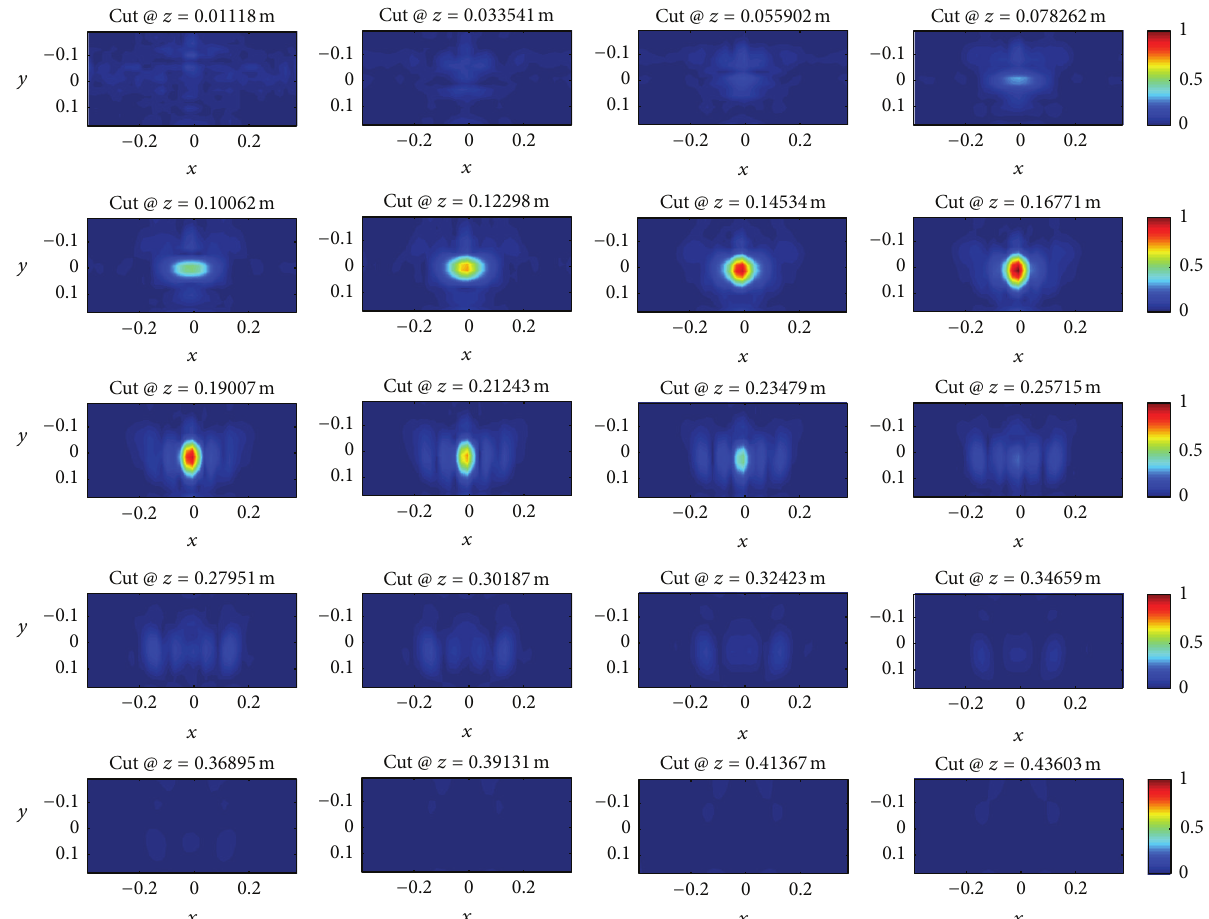
Figure 9: Depth slices of the contrast function reconstructed by processing the data set referred to a vacuum sphere as in Figure 5.